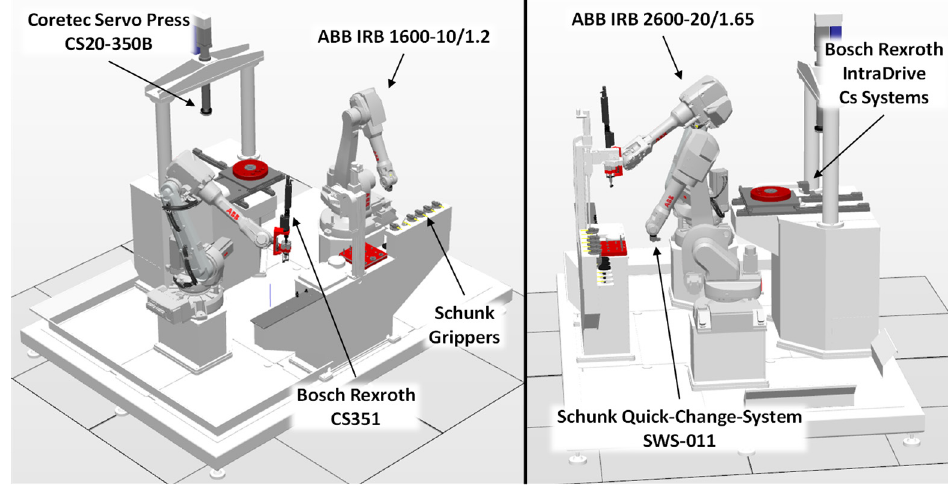
Figure 4. Full view of the assembly cell reproduced in RobotStudio 3D environment.